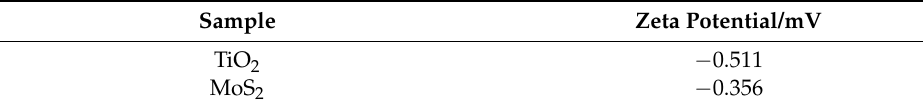
Figure 1. Zeta potential diagram of TiO 2 and MoS 2 . Table 1. Electronegativity of TiO 2 and MoS 2 . Table 1. Electronegativity of TiO 2 and MoS 2